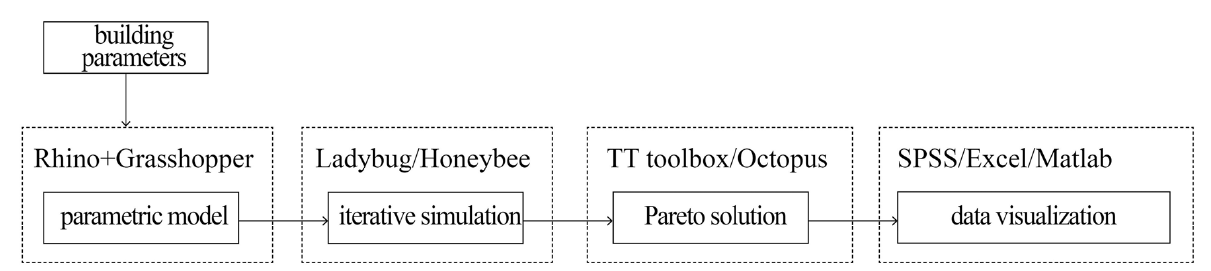
Figure 3. Parametric building optimization